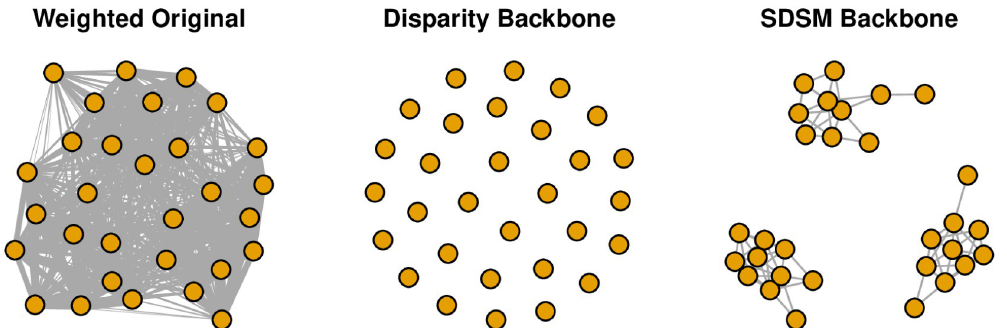
Fig 4. Extracting the backbone of a bipartite projection (toy